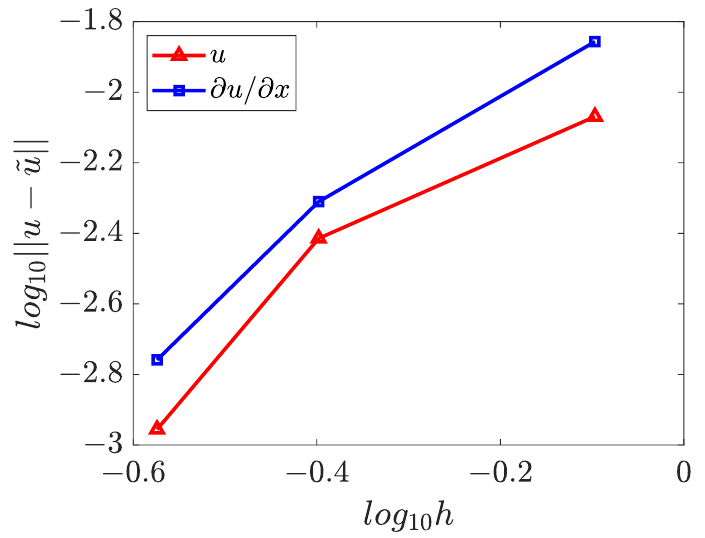
Figure 11. Convergence of the solutions for the 2D constant parameter identification problem in irregular geometry.